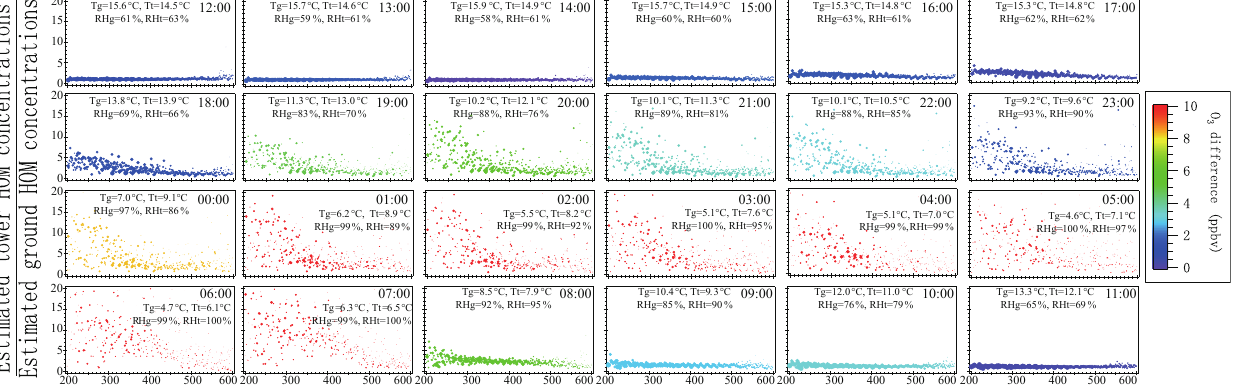
Figure 9. Hourly changes of the ratios between estimated tower and ground HOM concentrations from 12:00 on 8 September to 11:00 on 9 September (inversion night). Markers are sized by ground HOM concentrations and colored by the O3 difference between tower and ground − O ( O 3 3 ground ) . Hourly ambient temperatures at ground (Tg) and tower (Tt) levels and RH at ground (RHg) and tower (RHt) levels are tower shown in each